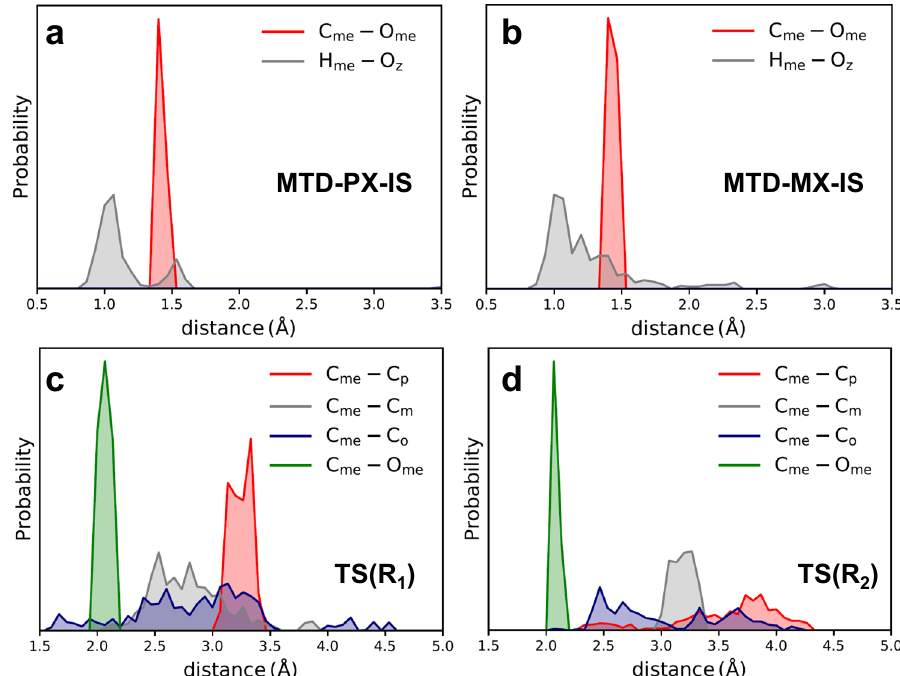
Fig. 4 Structural analysis of IS and TS regions. Frequency distribution of distance between atoms in a MTD – PX – IS, b MTD – MX – IS, c TS(R 1 ), and d TS(R 2 ) regions in MTD – PX and MTD – MX